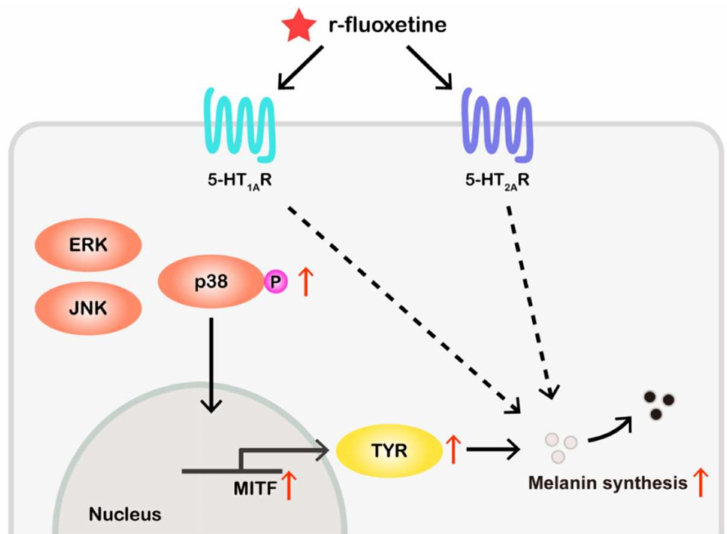
Figure 8. Schematic description of the changes in melanin synthesis induced by r-fluoxetine. Red arrow define the activity of r-fluoxetine, black arrow define the direct stimulatory modification, dotted arrow define the tentative stimulatory